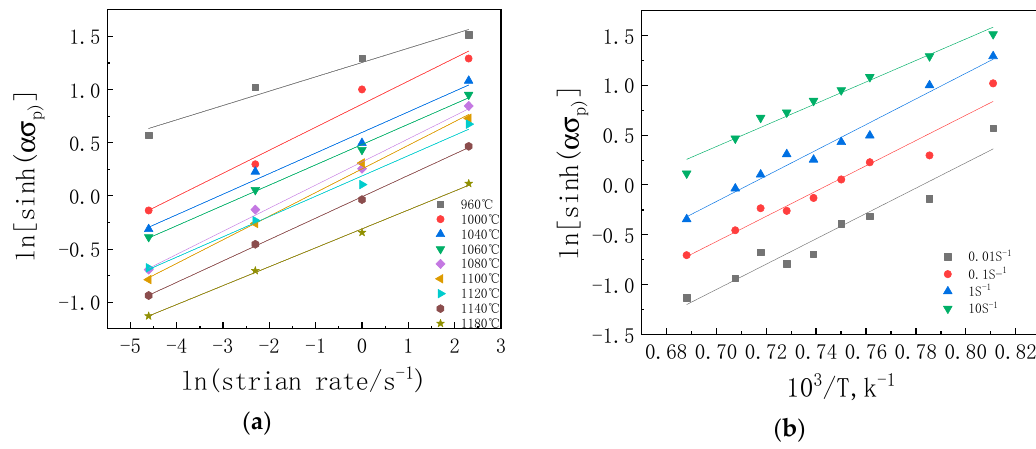
α σ p )); ( b ) ln(sinh( α σ p ))- T